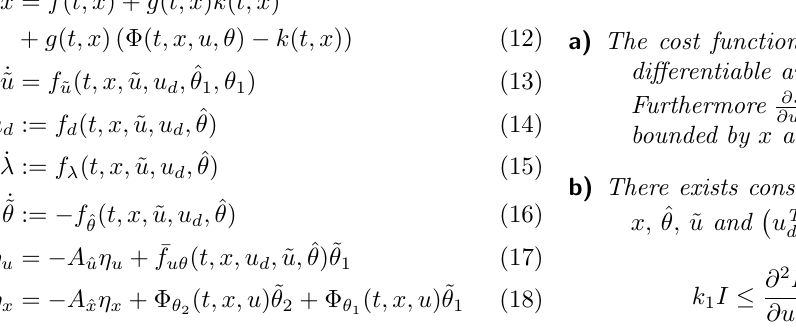
Assumpiton 3 (Optimal Control